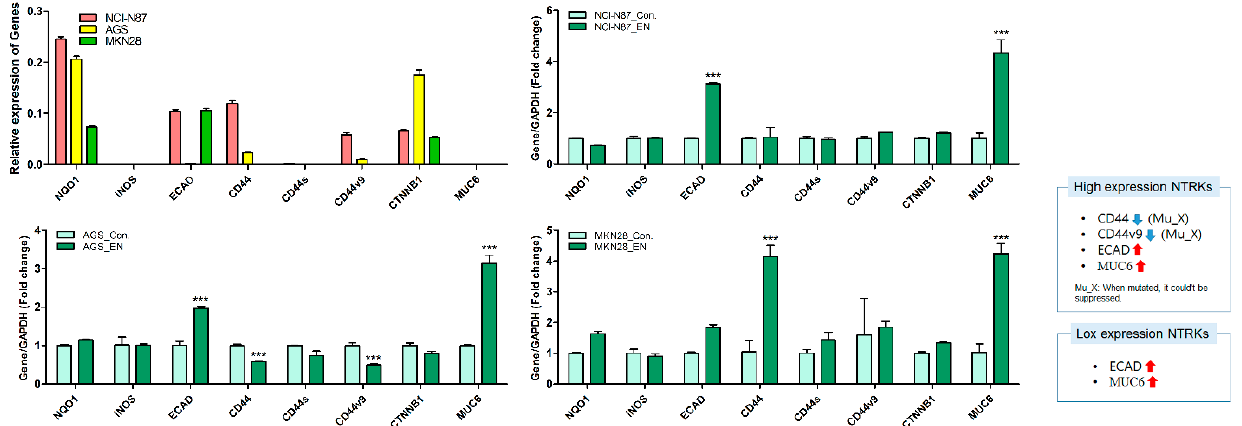
Figure 5. Effects of entrectinib on mRNA expression levels of EMT-related genes and antioxidant enzyme genes in gastric cancer cell lines (NCI-N87, AGS, and MKN28 cells). NQO1, iNOS, ECAD, CD44, CD44s, CD44v9, CTNNB1, and MUC6 mRNA expression levels were determined by quanti- tative reverse transcription-polymerase chain reaction (qPCR). *** p < 0.001 compared with control group. Mu, NTRK3 mutated cell lines; X, no inhibition.